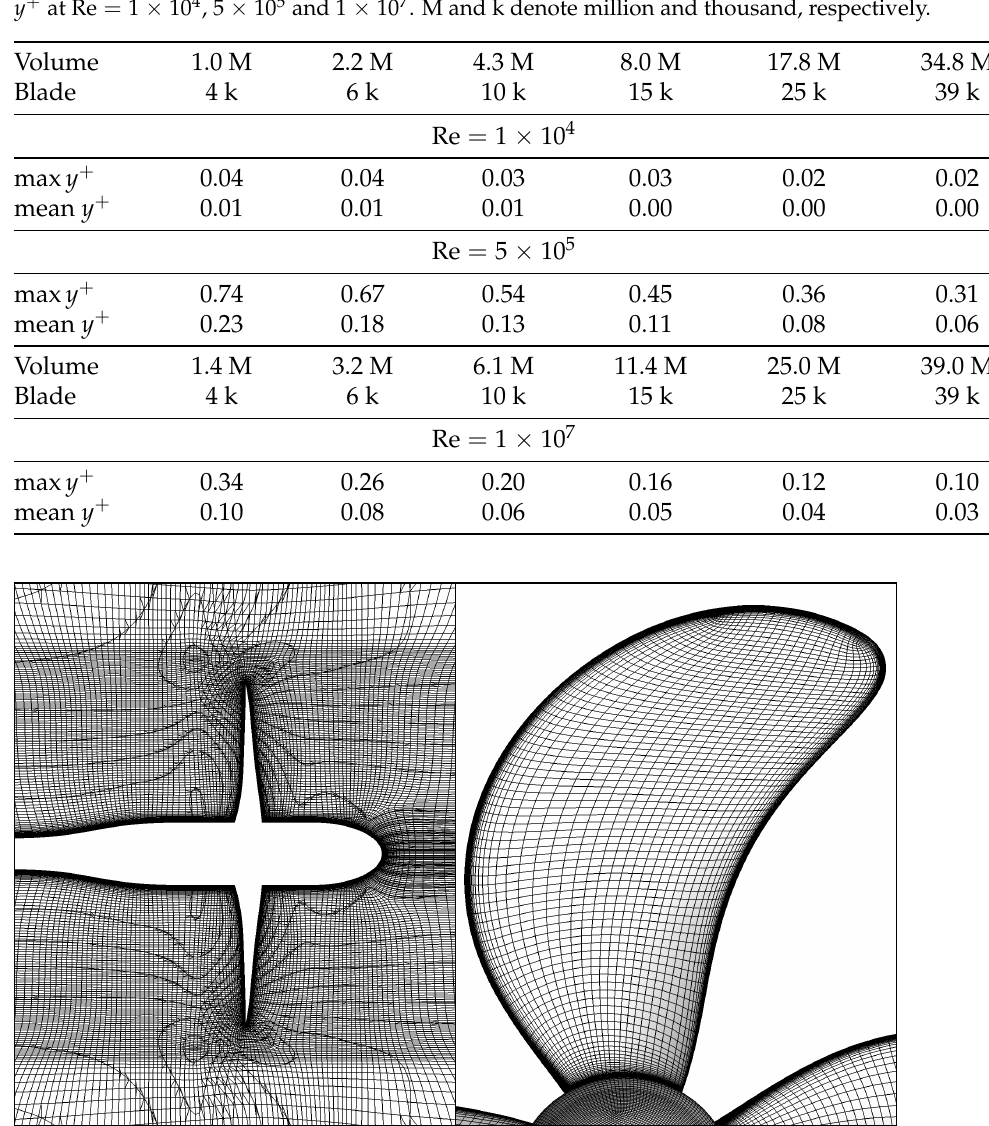
Figure 1. Overview of the grid around propeller and blades. Grid with 8.0 M